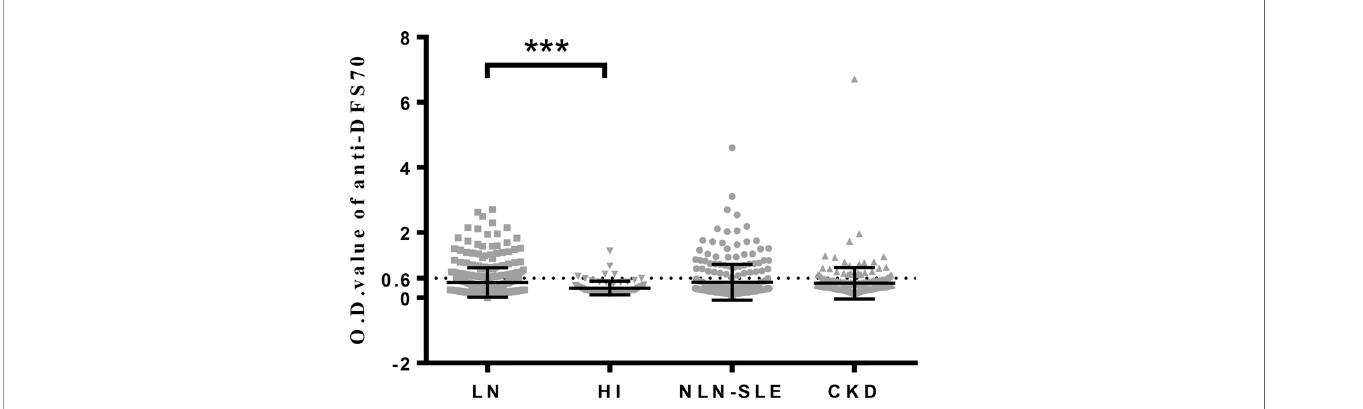
FIGURE 1 | O.D. values of anti-DFS70 antibodies in LN patients and three control groups (HI, NLN-SLE and CKD) measured by ELISA. CKD, chronic kidney disease; DFS70, dense fi ne speckles 70; ELISA, enzyme-linked immunosorbent assay; HI, healthy individuals; LN, lupus nephritis; NLN-SLE, non-LN systemic lupus erythematosus; O.D. value, optical density value. The dotted line at 0.6 indicates the O.D. cutoff value for anti-DFS70 antibodies. *** P <